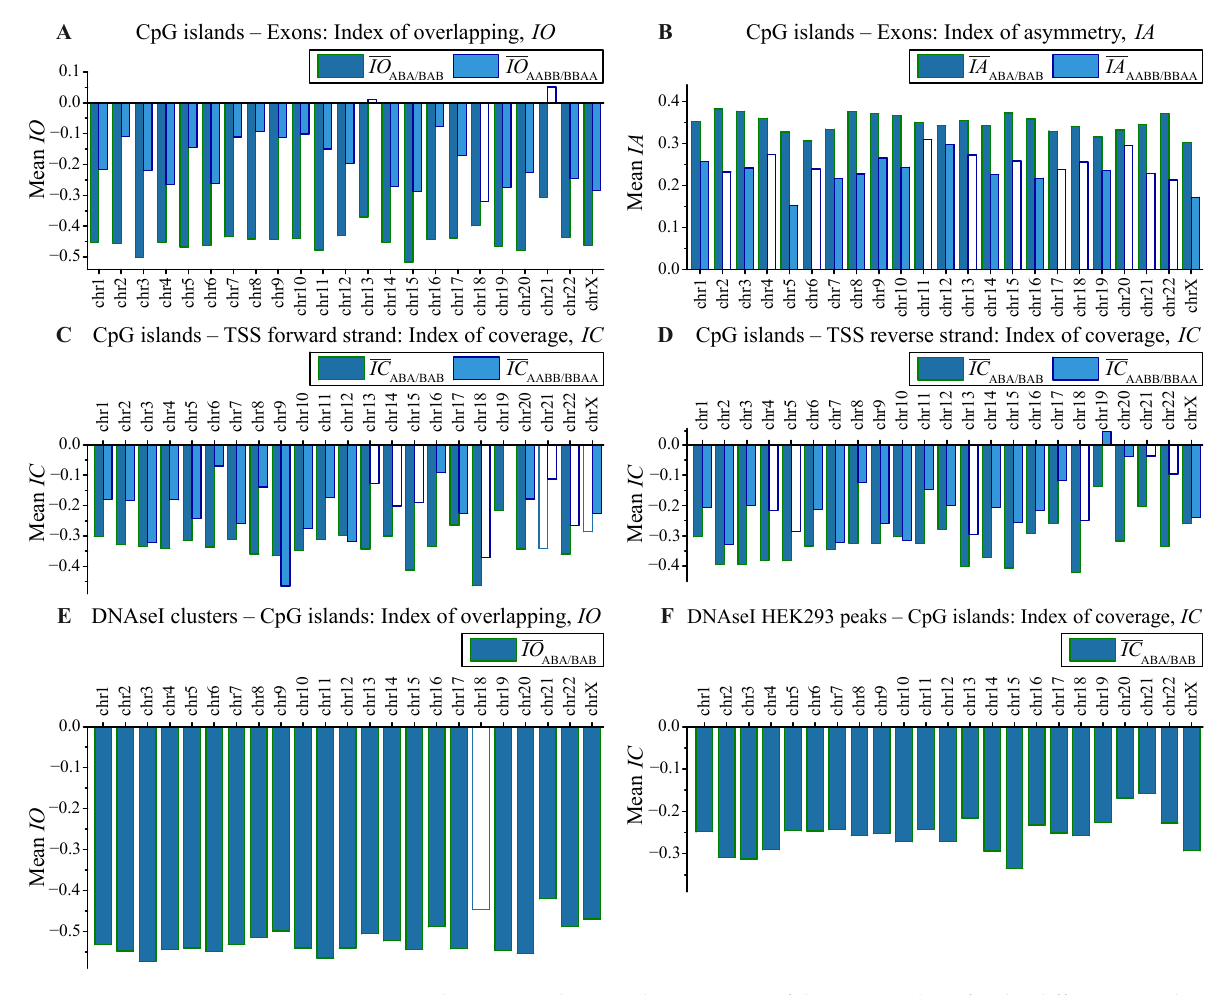
Figure 5. Distribution over human chromosomes of the mean indices for the different stretches. Mean index of: ( A ) overlapping (Equation (1)) for CpG islands and exons; ( B ) asymmetry (Equation (2)) for CpG islands and exons; ( C ) coverage (Equation (3)) for CpG islands and TSS on the forward strand; ( D ) coverage (Equation (3)) for CpG islands and TSS on the reverse strand; ( E ) overlapping (Equation (1)) for DNAseI clusters and CpG islands; ( F ) coverage (Equation (3)) for DNAseI HEK293 peaks and CpG islands. Non-filled bars indicate chromosomes for which the index values are not statistically significant (| z | < 1.96, p >